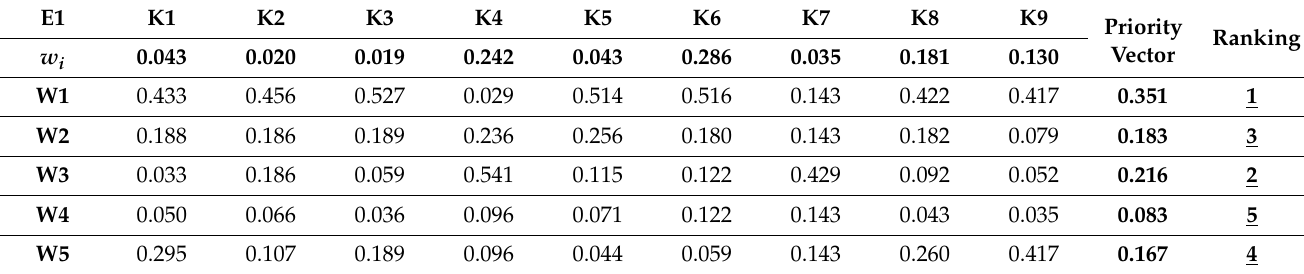
Table 3. Ranked list of the final weight distributions of the respective equipment variants according to Expert 1.